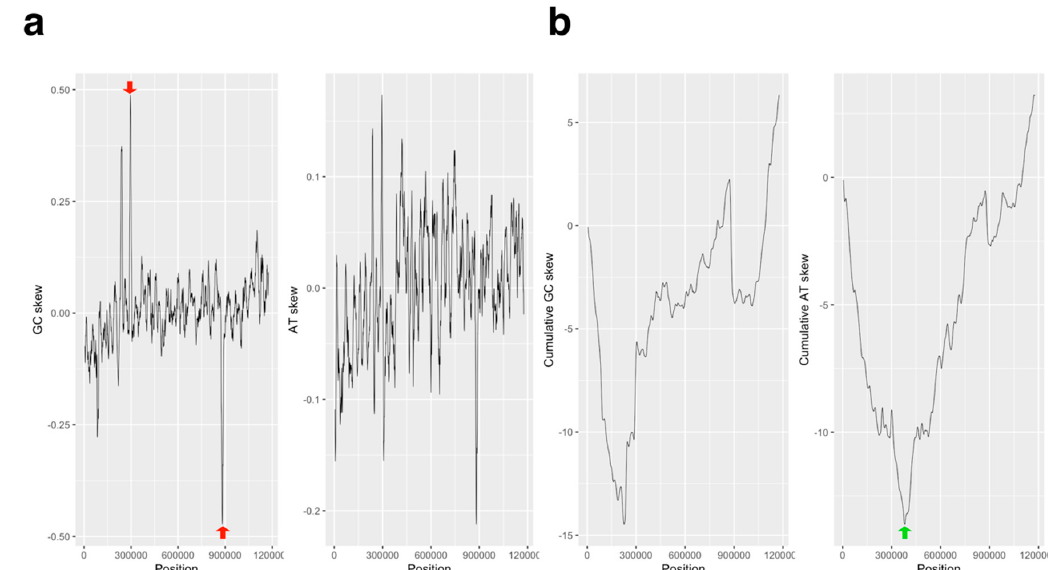
Figure 1. Analyses of the GC/AT skew in the Acanthamoeba polyphaga mimivirus (APMV) genome. ( a ) GC and AT skew plot of APMV genome (AY653733.1, step size: 1000 bp; window size: 10,001 bp). Red arrows on the GC skew plot indicate the highest/lowest peaks, which are located at the symmetrical position of the genome (GC skew: 0.488234 at 296,000 bp; -0.472989 at 882,000 bp). ( b ) Cumulative GC and AT skew plots corresponding to the graphs on the panel (a). The green arrow on the graph on the cumulative AT skew plot shows the lowest valley point on this graph, which was estimated in the genomic region as an origin of replication (382,000 ± 5000 bp).